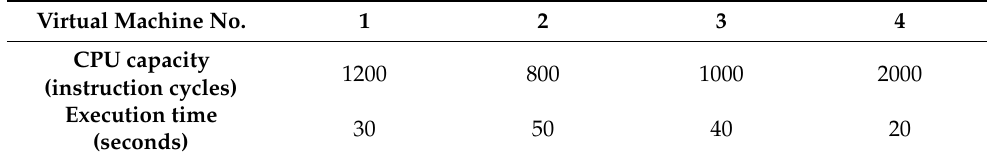
Table 4. Configuration of 4 virtual machines for scenario 2.